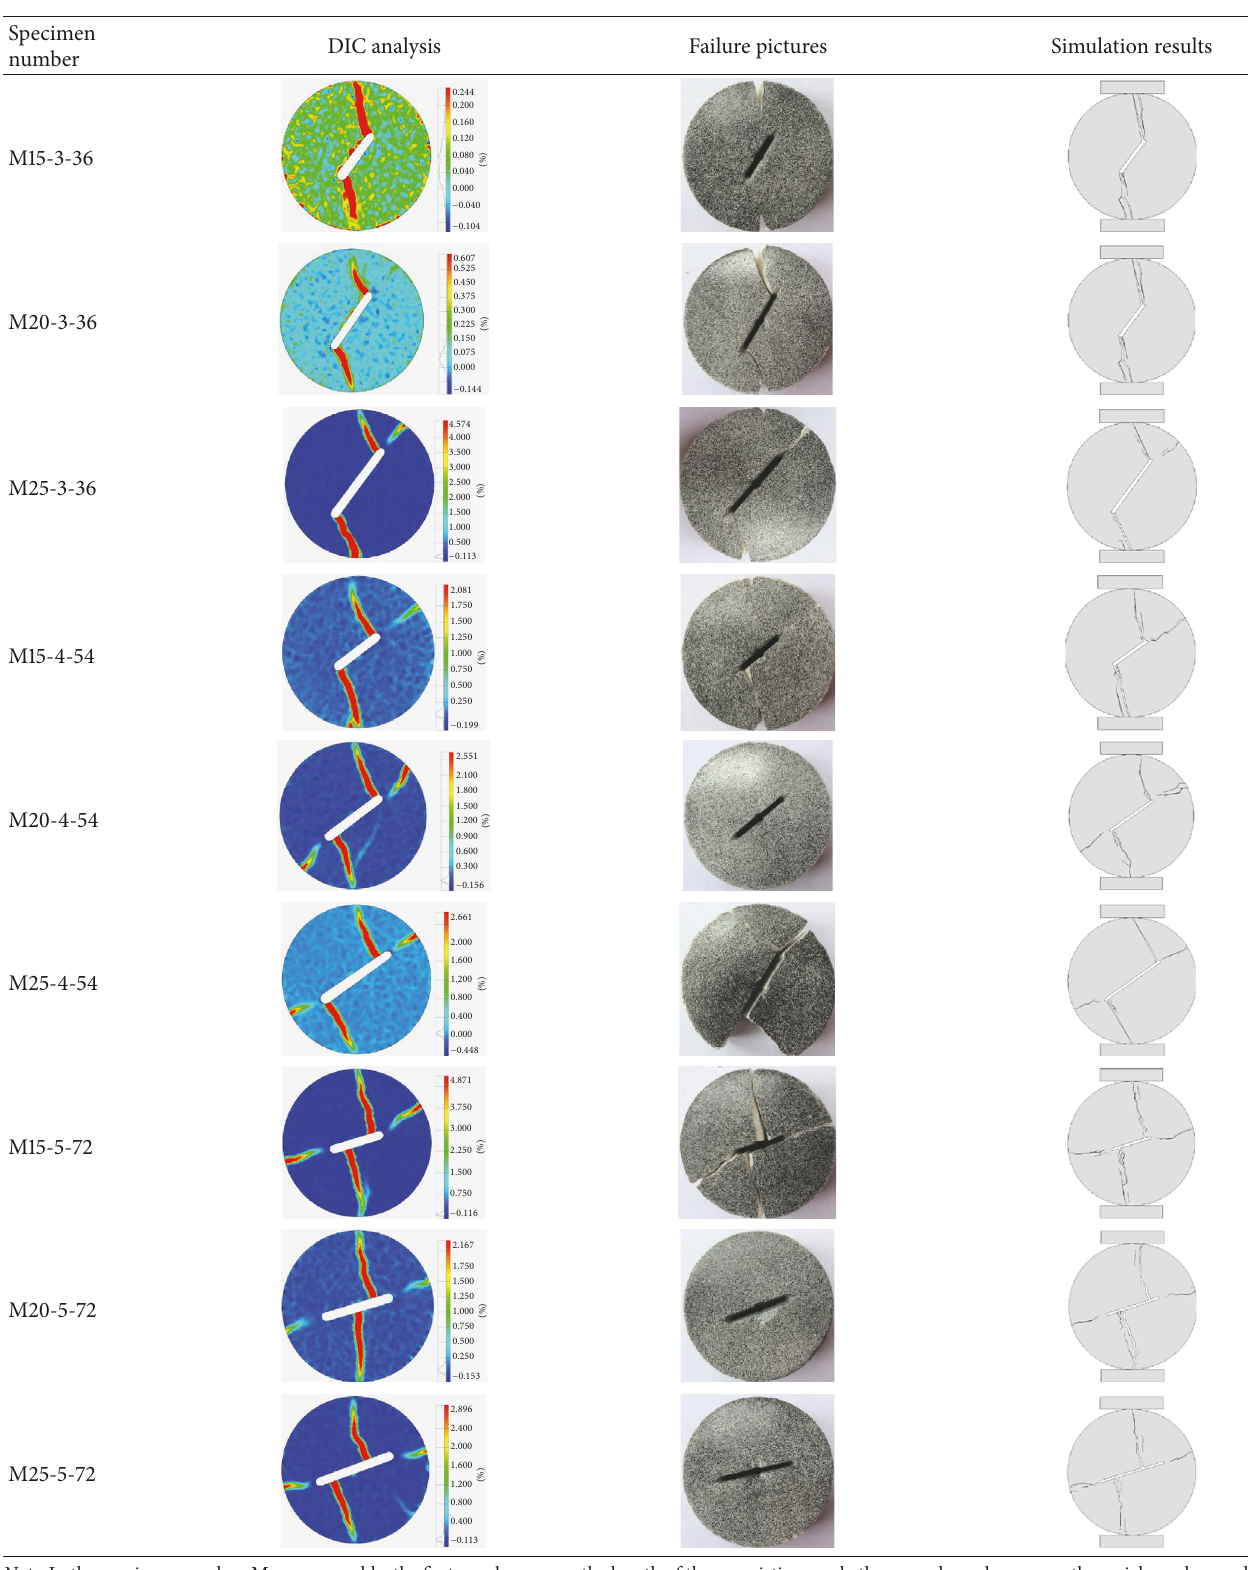
Table 3: Comparison of DIC analysis, failure pictures, and simulation